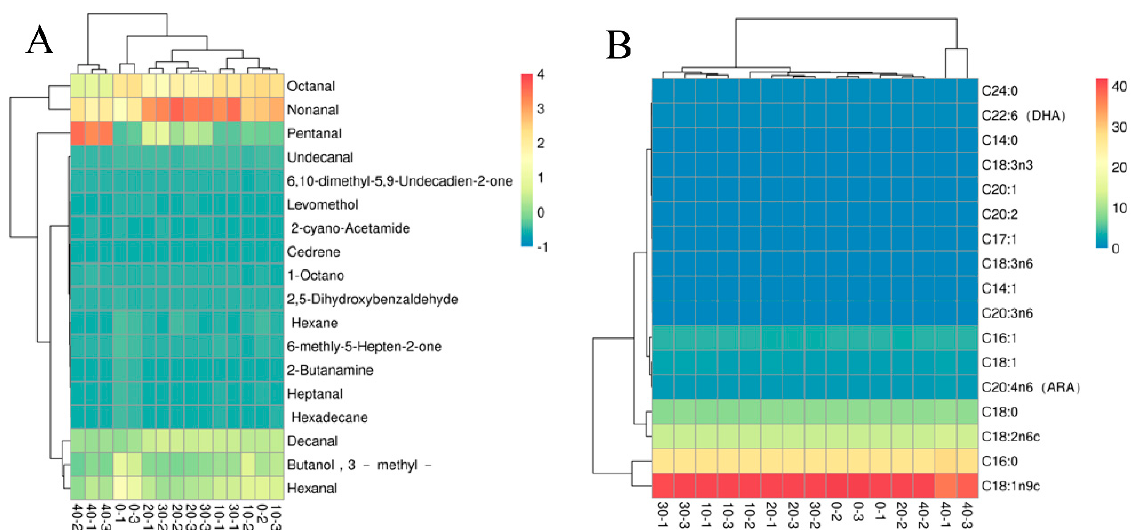
Figure 4. Heat map of volatiles and fatty acids of egg yolk at different ozone treatment times. ( A ) The volatiles; ( B ) fatty acids.